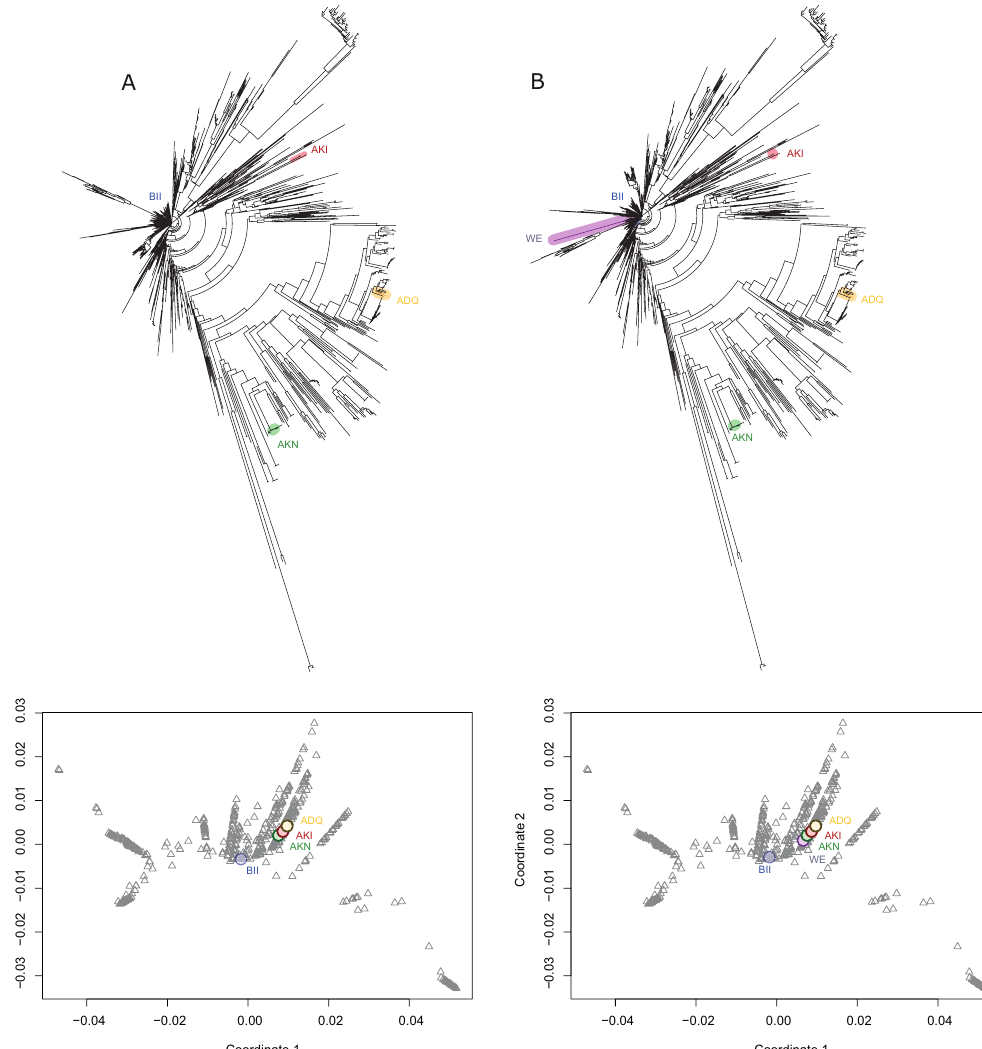
Figure 3. Representative yeast strains in the context of the population structure of the species. ( A ) TE tree highlighting the position of four strains (BII: DBVPG1106; AKI: DBVPG6044; ADQ: K12 and AKN: YPS128), which are representative of four yeast clean lineages. ( B ) TE tree considering also the DBVPG6765 (WE) strain. Below each TE tree bi-dimensional tree space representation is showed, obtained from the phylogenetic distance matrix among strains. The positions of the representative strains are